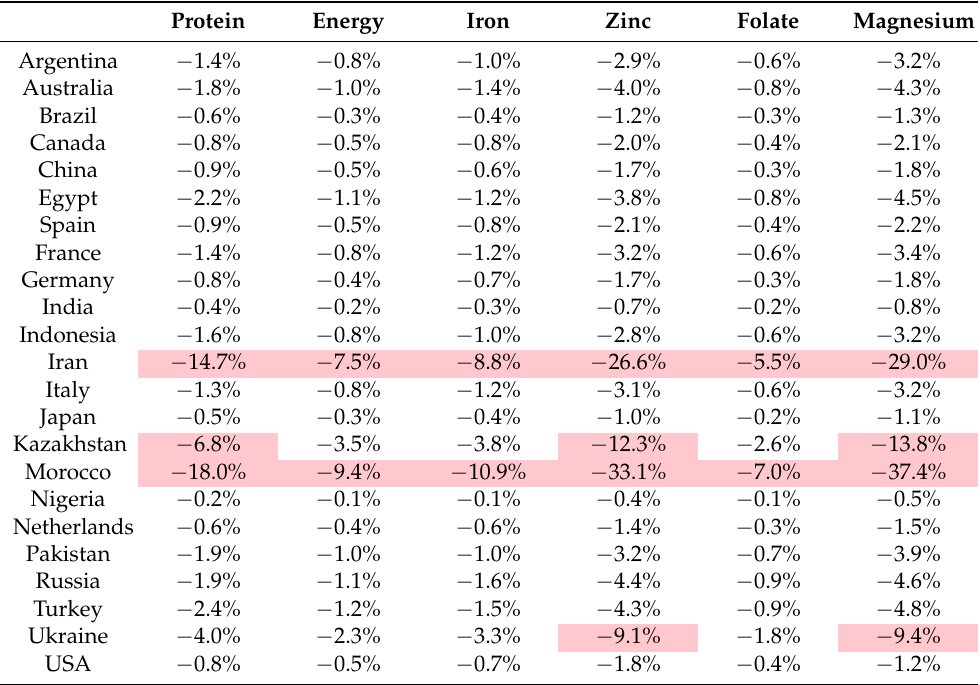
Table 4. Nutrition at risk (NAR) values, productivity shocks (Scenario Y) *. Protein Energy Iron Zinc Folate